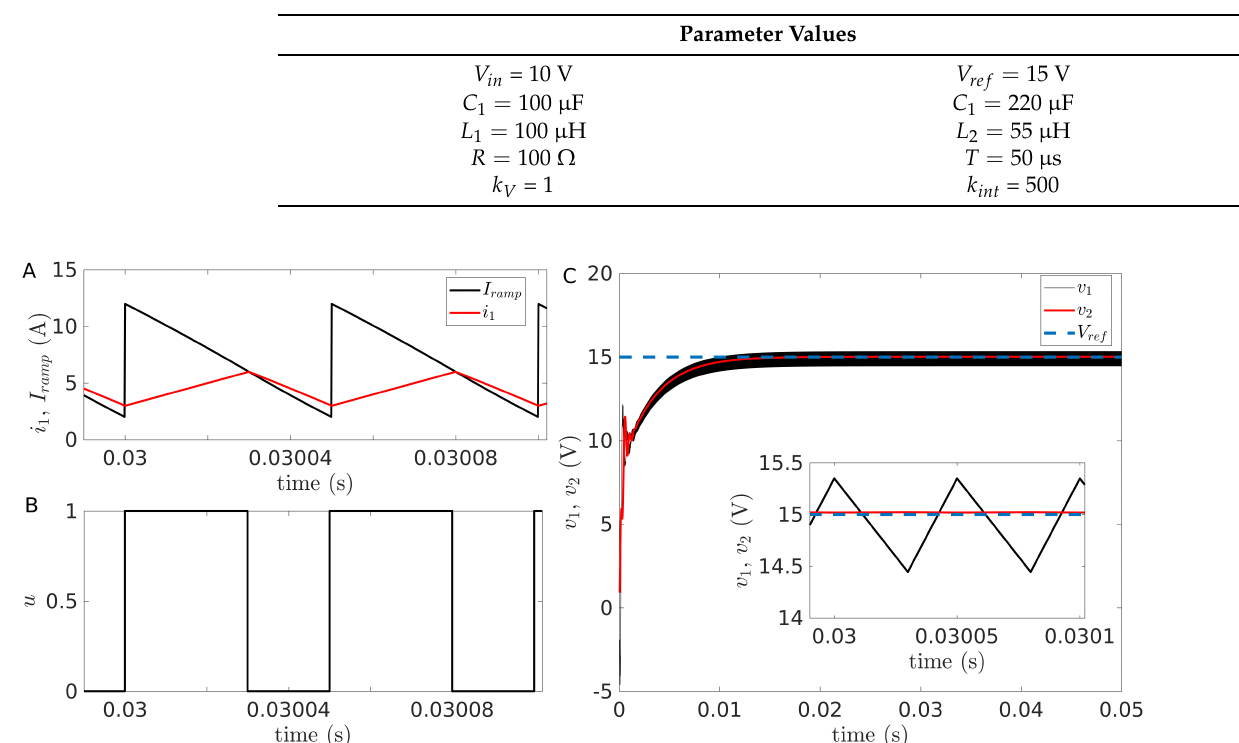
Table 1. Parameter values used throughout the paper.